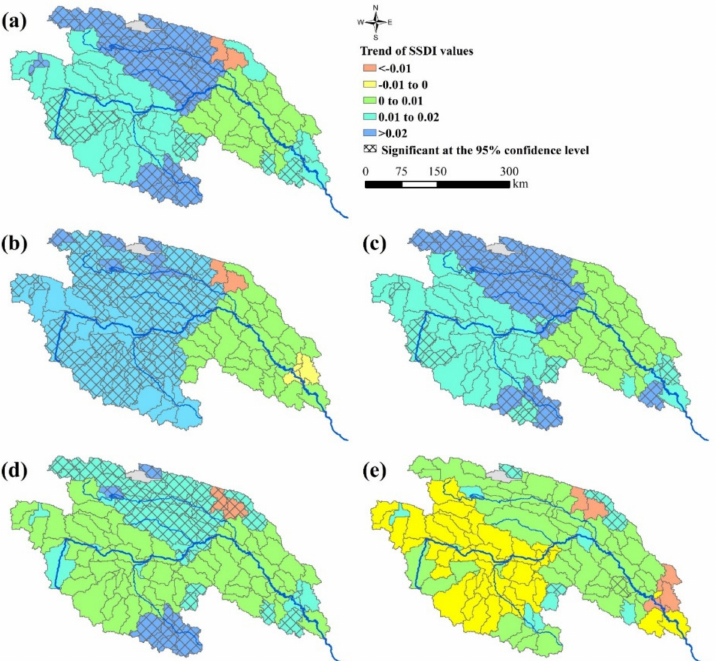
Figure 5. The trend of SSDI values during 1960–2016: ( a ) SSDI-12m of December; ( b ) SSDI-3m of May; ( c ) SSDI-3m of August; ( d ) SSDI-3m of November; ( e ) SSDI-3m of February. The crosshatch indicates that the trend is statistically significant at the 95% confidence level based on Mann–Kendall